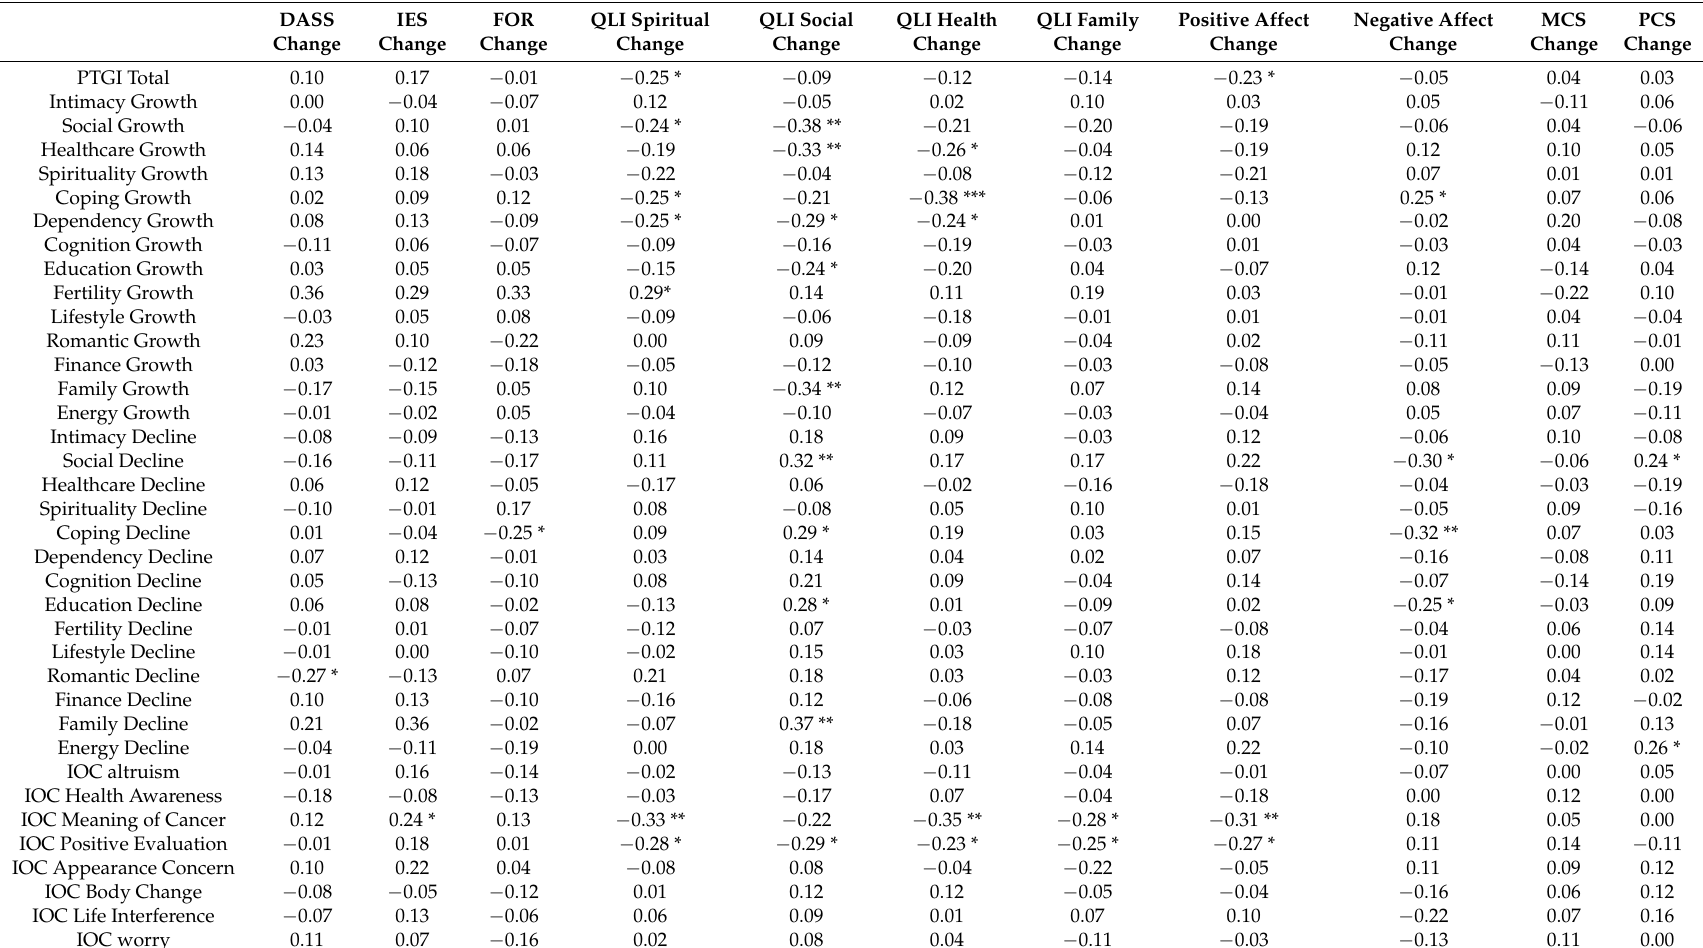
Table 3. Bivariate Correlational Analysis of T1 PPTG with to T2-T1 change in